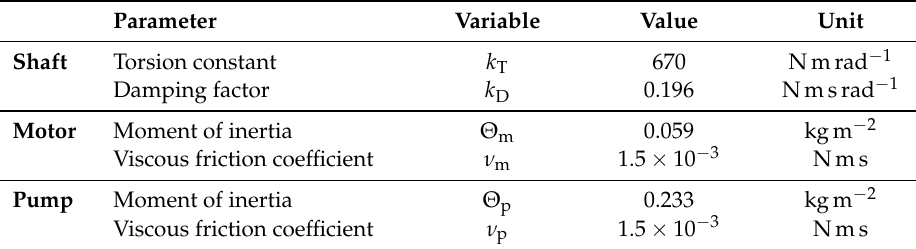
Table 3. Simulation parameters of the mechanical